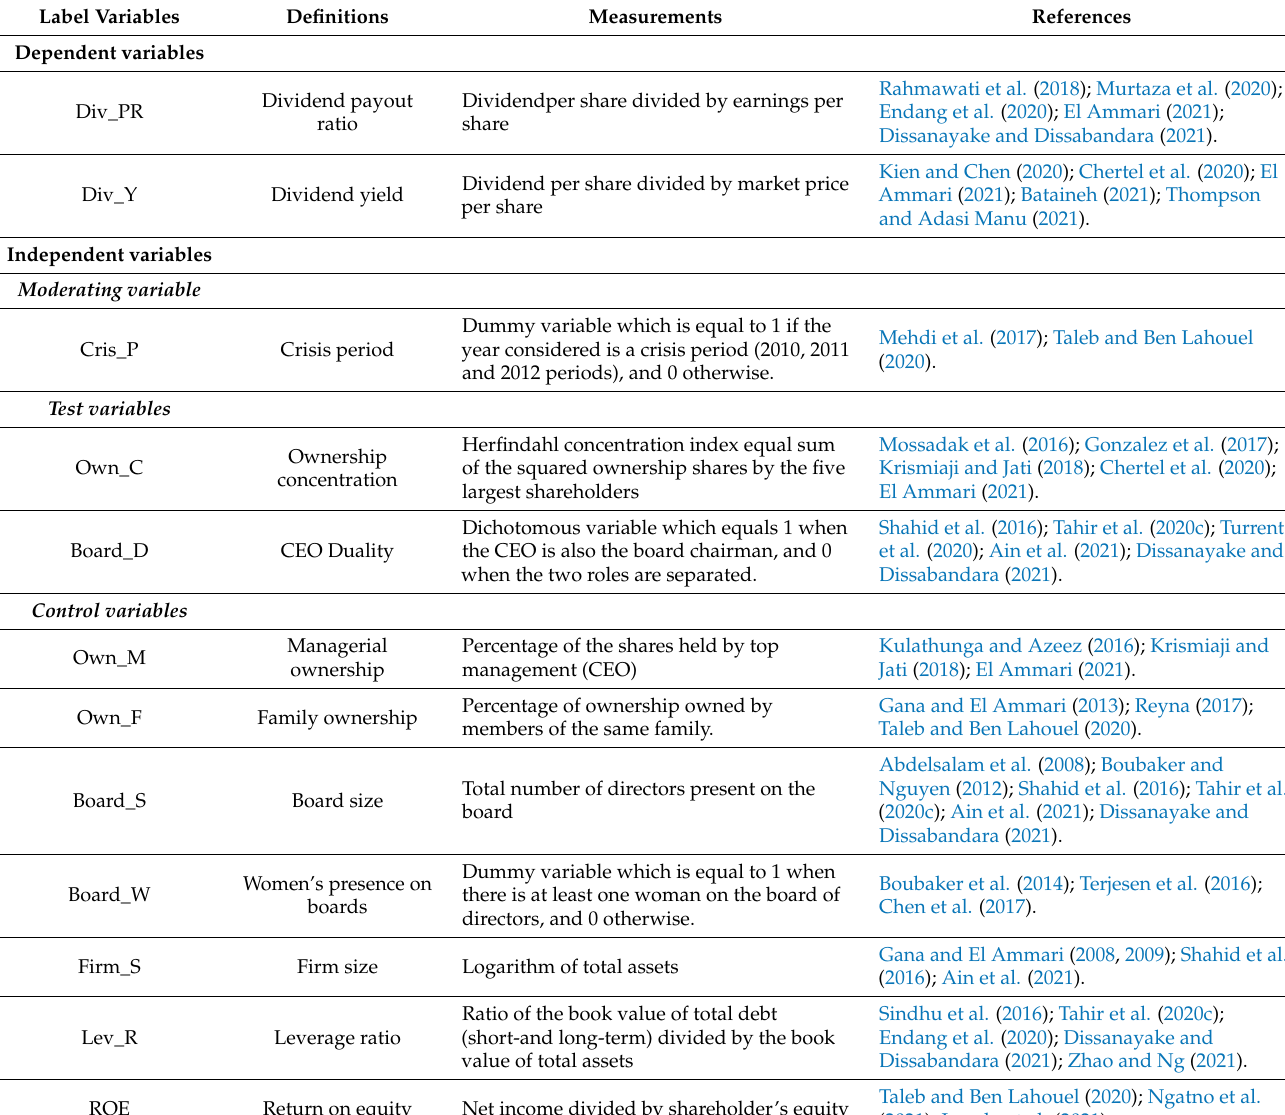
Table 1 below provides full descriptions of all the different variables used in this study. Table 1. Variable definitions and